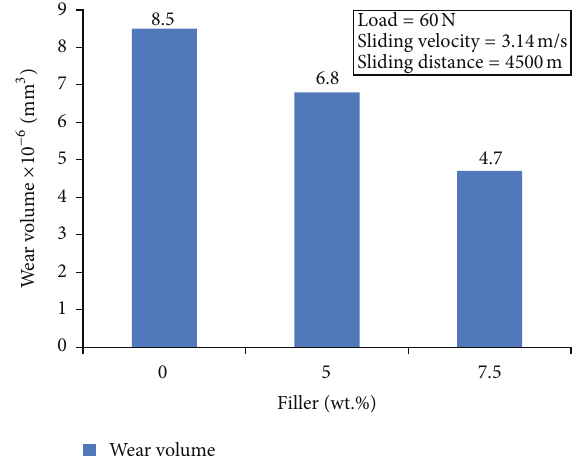
Figure 10: Wear volume of SiO 2 filled G-E